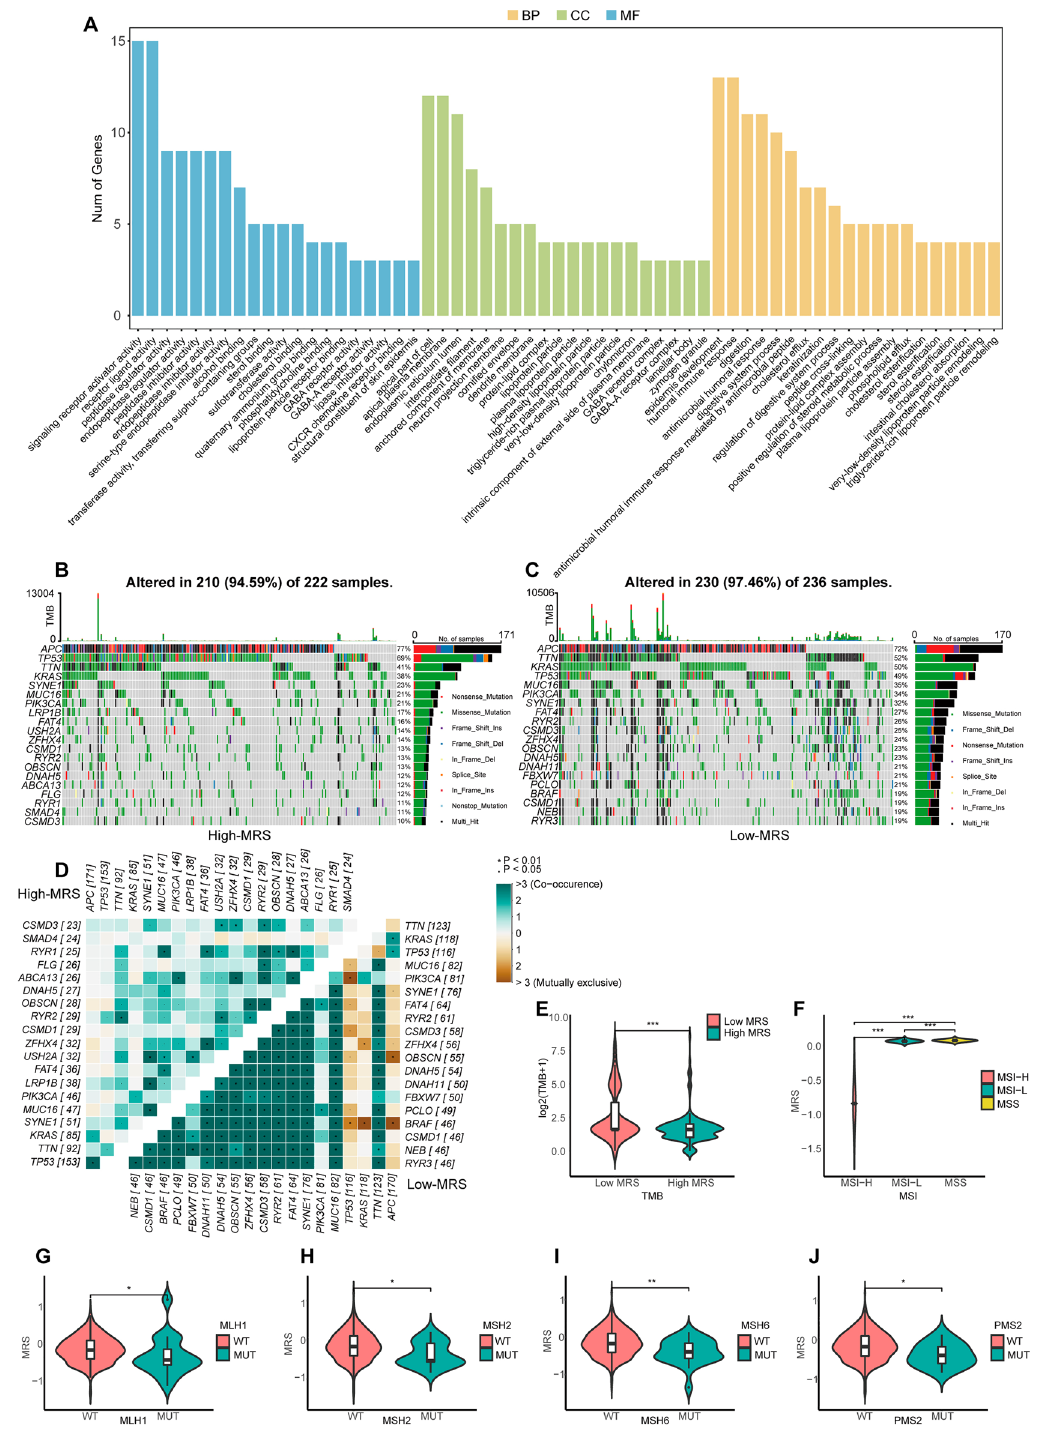
Figure 4. Mutational profiles in different MRS patient subgroups. ( A ) Enrichment analyses for genes differentially expressed in the different MRS patient subgroups. ( B , C ) The top 20 genes exhibiting the highest mutational frequencies in patients with high ( B ) and low MRS scores ( C ) were visualized by the maftools package for R language (version 4.1.2). ( D ) The co-occurrence and mutual exclusivity of the genes with the top 20 mutational frequency values in the high- and low-MRS subgroups, were plotted using the somaticinteraction function in the maftools package of the R language (version 4.1.2). ( E ) The association between TMB and MRS subgroups. ( F ) The association between MSI and MRS subgroups. ( G – J ) The association between MRS subgroups and the mutational status of the MLH1 ( G ), MSH2 ( H ), MSH6 ( I ), and PMS2 ( J ) genes. *P < 0.05; **P < 0.01; ***P <